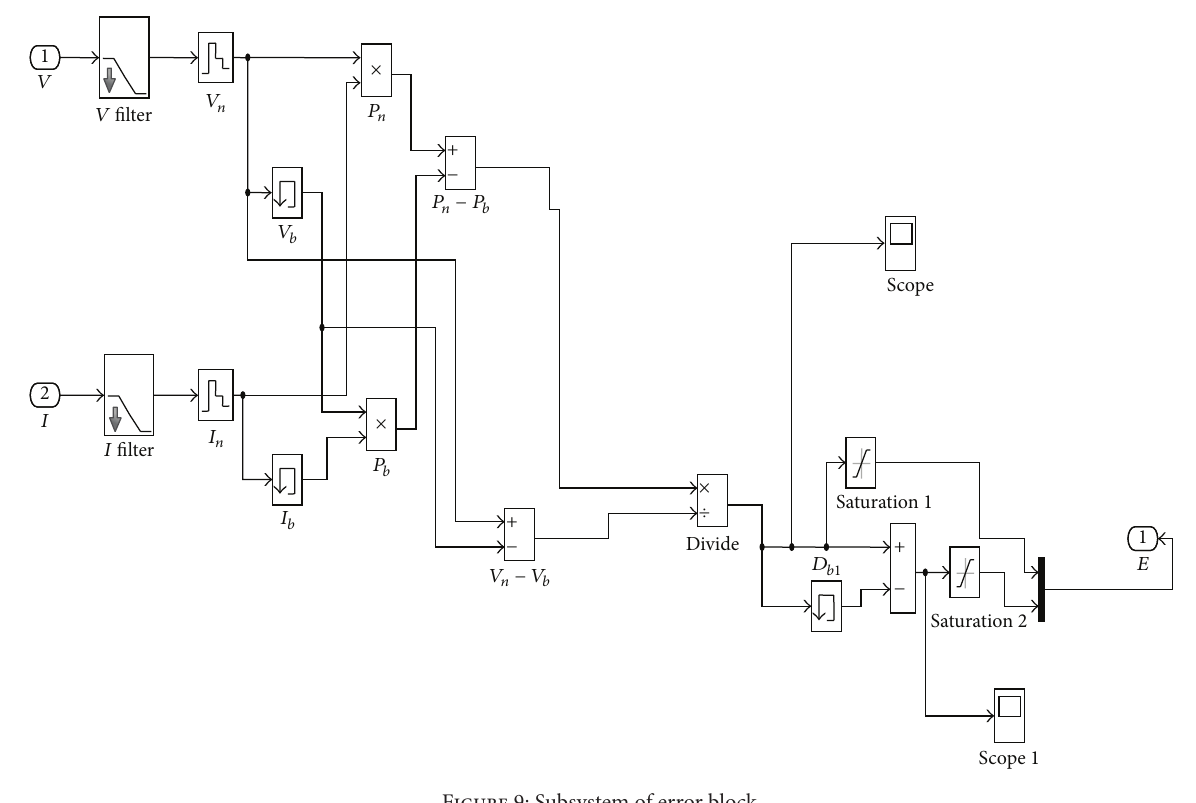
Figure 9: Subsystem of error block.